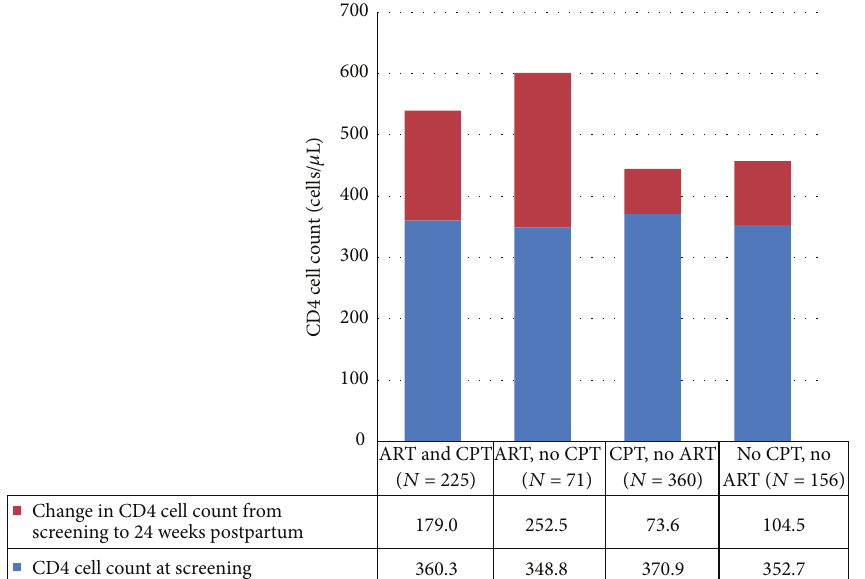
Figure2:MeanCD4cellcountduringpregnancyandmeanchangeinCD4cellcountfromscreeningto24weekspostpartuminHIV-infected women during and after pregnancy.